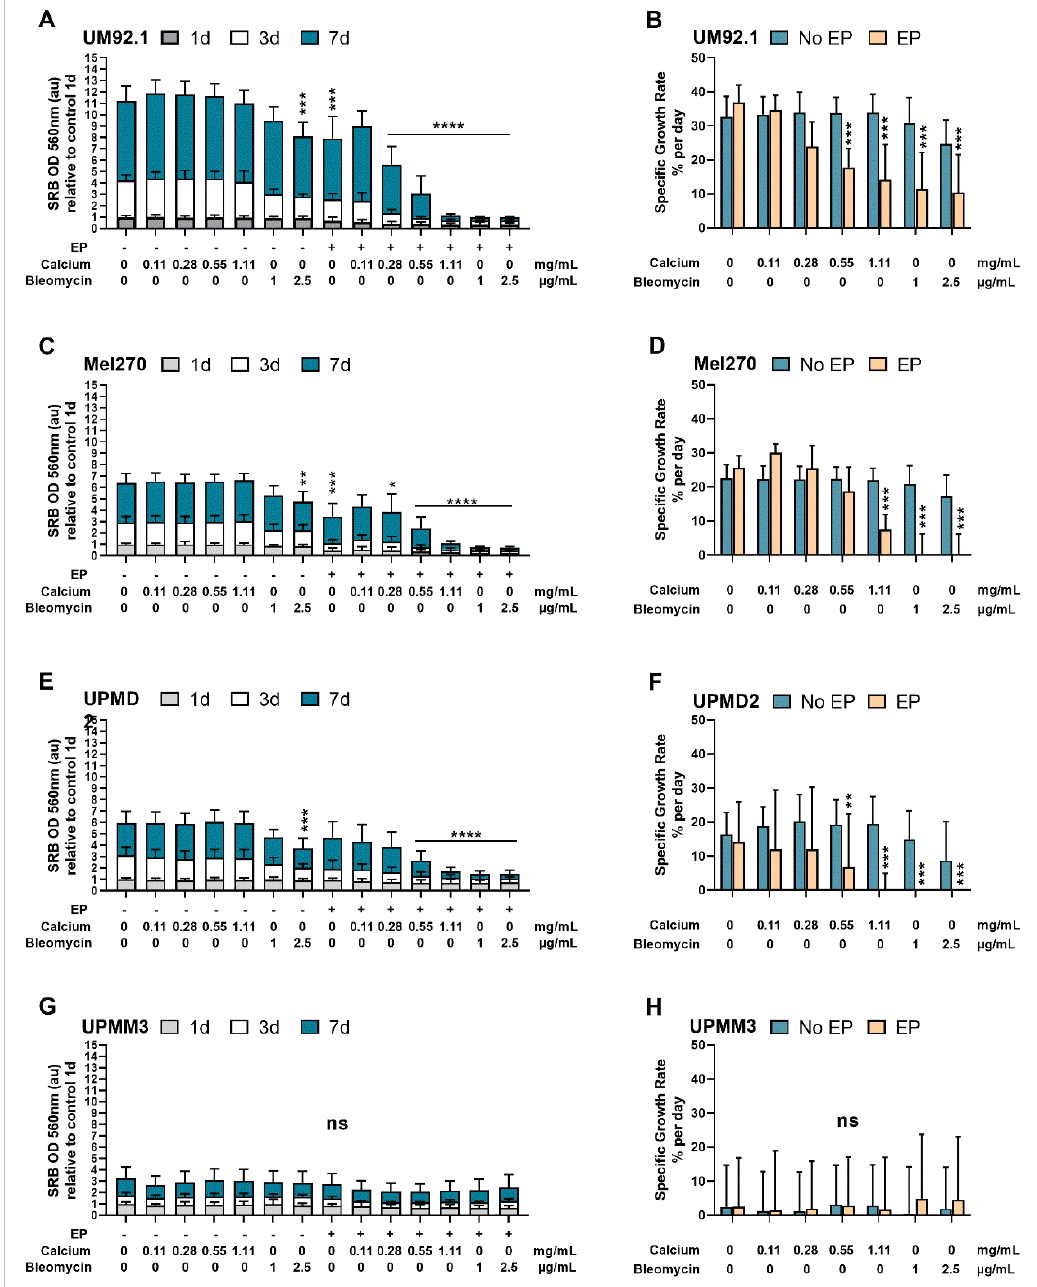
Figure 3. Effects of CaEP and ECT on cell viability and cell growth. The different UM cell lines. ( A , B ) UM92.1, ( C , D ) Mel270, ( E , F ) UPMD2, and ( G , H ) UPMM3 were exposed to calcium chloride (0.11, 0.28, 0.55 or 1.11 mg/mL) or bleomycin (1 or 2.5 µ g/mL). EP was conducted with 1000 V/cm pulse strength, 100 µ s pulse duration, and 5 Hz repetition frequency. Untreated cells, calcium chloride alone, bleomycin alone (no EP group), or EP alone constitute the control groups. The cell count and, therefore, the cytotoxic effect (N = 3–4; n = 8 each condition) were assessed by measuring SRB absorbance values at 560 nm cell cultures stained with SRB on day 1 (1 d), 3 (3 d), and 7 (7 d) after treatment ( A , C , E , G ). The data are shown as absorbance units (au) (mean values ± SD). Cell line- specific growth rates in percentage per day (mean ± SD) were calculated and statistically compared to the control groups ( B , D , F , H ). Statistical analysis was performed using a two-way ANOVA and Tukey’s multiple comparisons test.; significance levels are indicated with * p < 0.05, ** p < 0.01, *** p < 0.001, **** p <